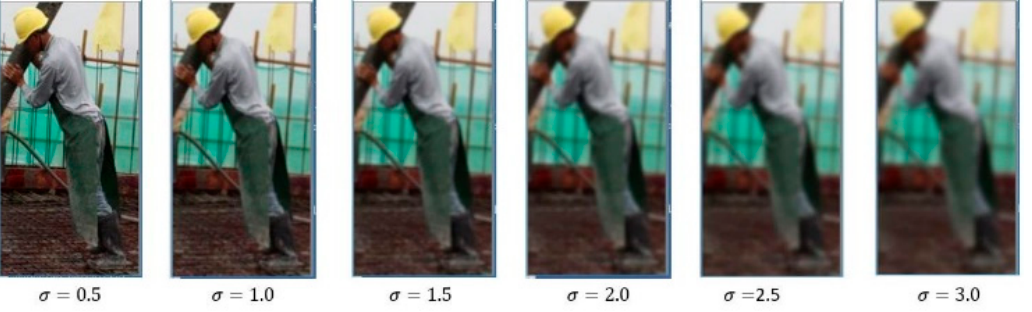
Figure 4. Effect of different blurring degrees.